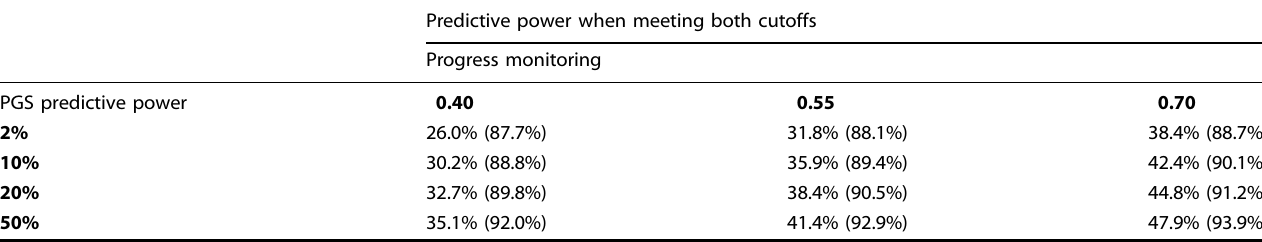
Table 4. Positive and negative predictive value of progress monitoring tools and PGS (meeting criteria of both) as a screener for learning disabilities (tenth percentile or lower achievement).